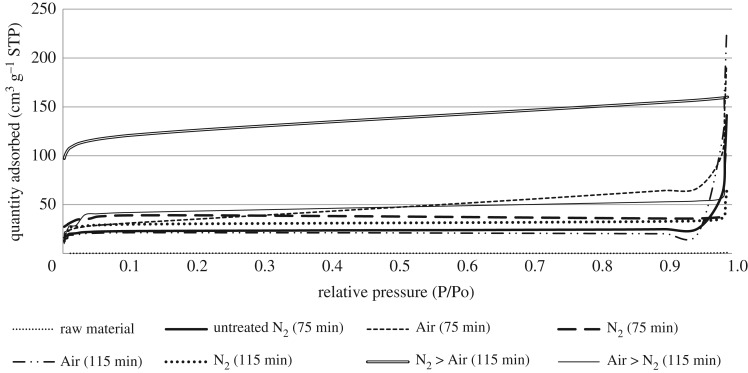
N2-Adsorption isotherm for the sample at 77 K for CS bioadsorbent.